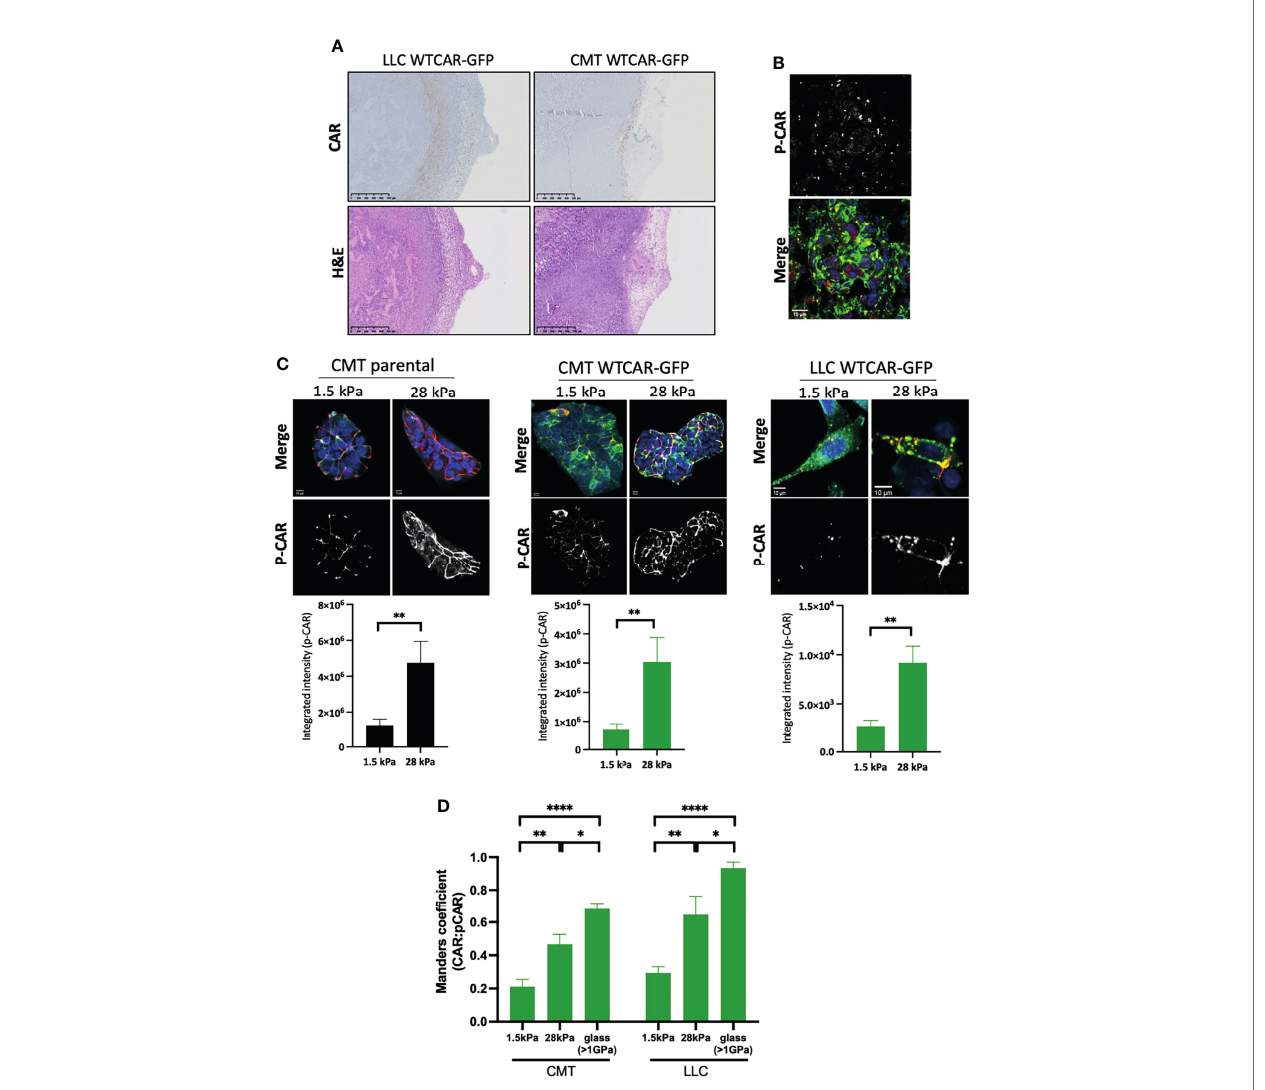
FIGURE 4 | CAR is a mechano-responsive protein. (A) Representative images of sections from tumors formed following subcutaneous injection of LLC or CMT cells stably expressing WTCAR-GFP, stained for CAR (top panels, brown) or H&E (bottom panels). (B) Representative images of P-CAR staining of frozen sections of tumors formed following subcutaneous injection of CMT WTCAR-GFP expressing cell. Top panel shows P-CAR alone, bottom panel P-CAR (39), CAR-GFP (green) and DAPI (blue). (C) Representative confocal images of indicated cell lines plated on 1.5 kPa or 28 kPa stiffness plates, stained for P-CAR (bottom panels) and DAPI (blue). CAR is shown in green. Graphs beneath each image set show quanti fi cation of P-CAR from at least 10 fi elds of view per cell line, representative of 3 independent experiments. (D) Quanti fi cation of colocalization between CAR and P-CAR from images as in (C) from CMT and LLC cells expressing WTCAR-GFP. All values are mean ± SEM. P values *p < 0.05, **p < 0.01, ****p <